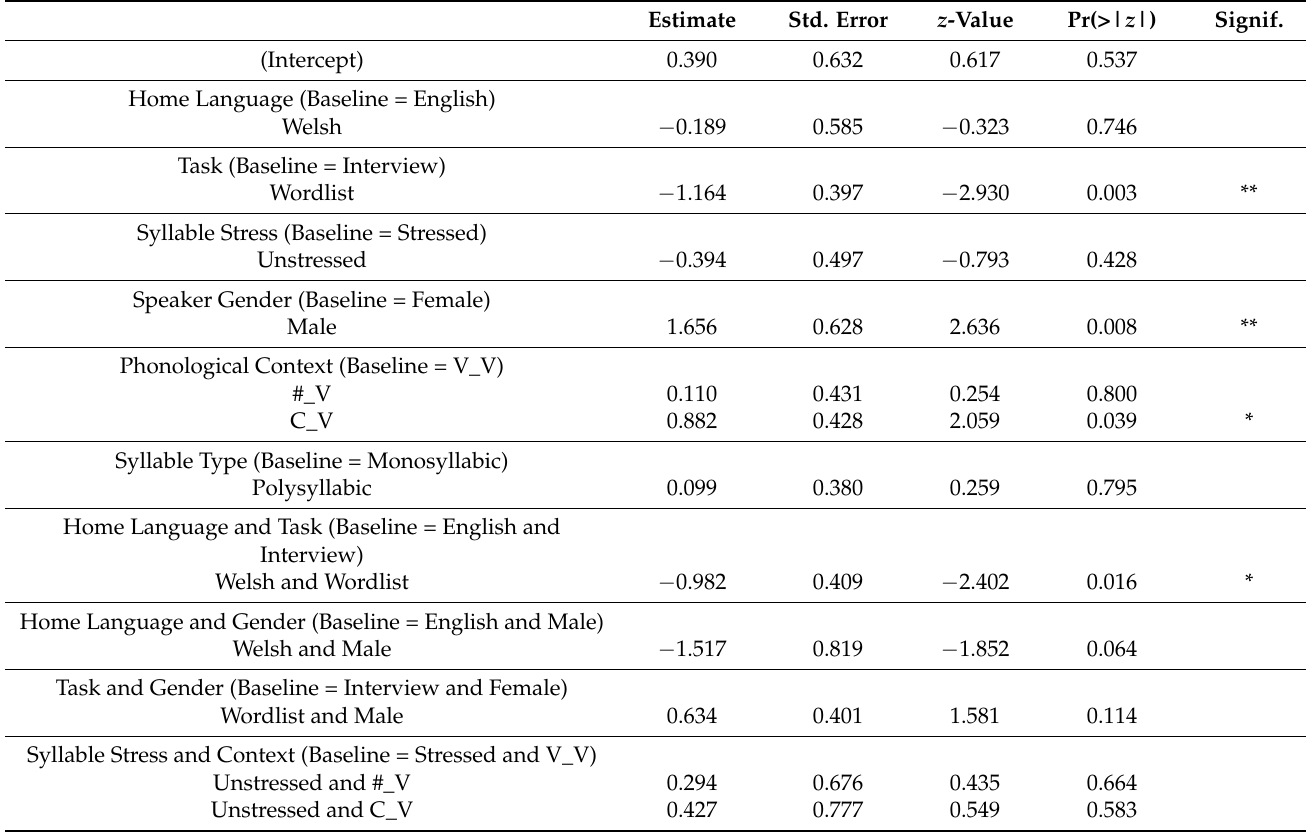
Table 8. Regression coefficients with z - and p -values for the final model predicting the production of the alveolar approximant in the Caernarfon Welsh-language subset ( n = 799). Positive estimates indicate an increased likelihood of the alveolar approximant. AIC =